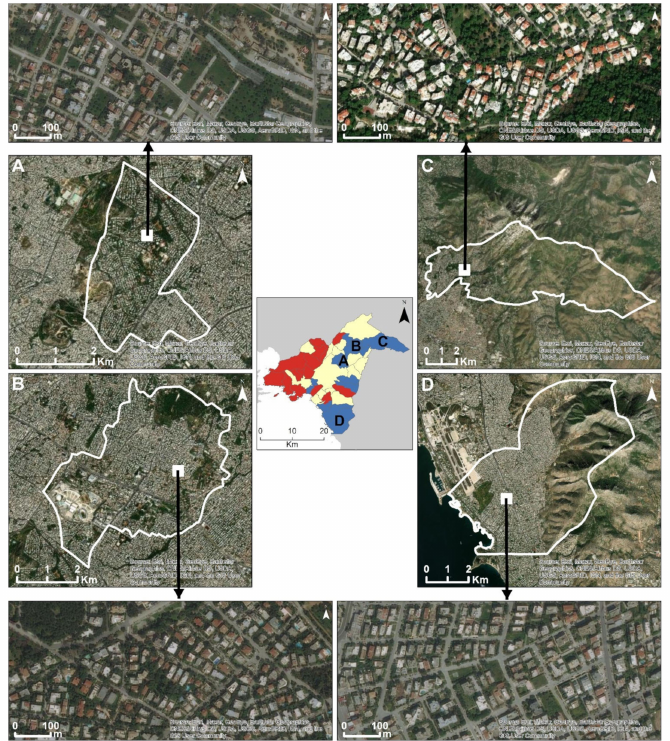
Figure 8. The urban background of advantageous municipalities. ( A ) Filothei-Psichiko